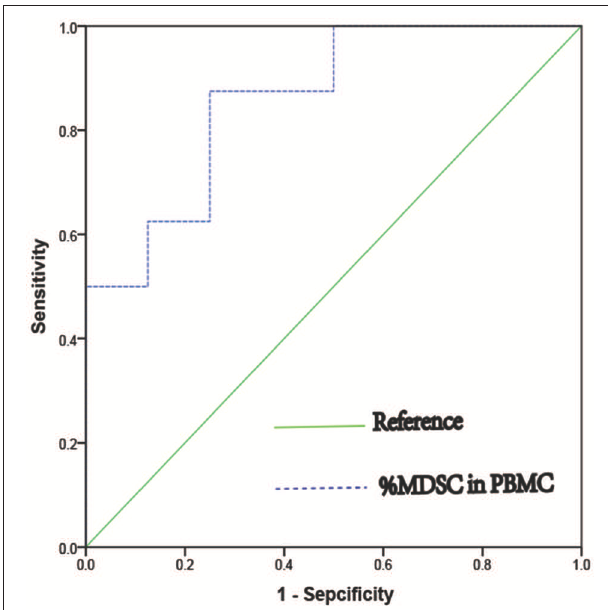
FIGURE 4 | ROC curve of percentage of MDSC in PBMC as a predict marker of clinical pregnancy in women who undergoing IVF treatment (AUC = 0.859, 95%CI = 0.677 – 1.000, * p = 0.016).